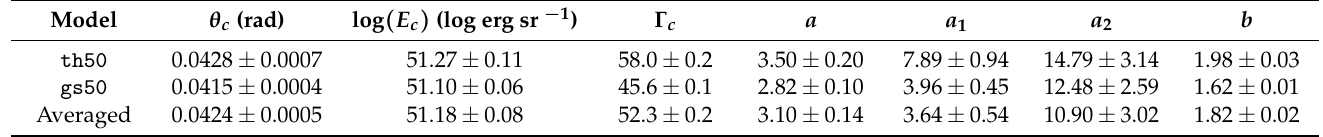
Figure 1. [Polar-plots] Face-on projections of the resultant jets/outflows. From the centre, θ = 0, to the edge, θ = 29 ◦ . Each row indicates a different initial jet structure described by: th50, gs50 , top to bottom. Where th indicates a top-hat profile for the injected jet structure, gs indicates a Gaussian structure, and the number is the logarithm of the jet power, i.e., 10 50 erg s − 1 . [ Left ]: The energy per steradian (erg sr − 1 ) for the resultant jet profiles. Energy per steradian is shown in the range 1 × 10 46 ≤ E/ Ω ≤ 7 × 10 51 erg sr − 1 . [ Centre ]: The resultant mass-averaged Lorentz factor for the same projection. Bulk Lorentz factor is shown in the range 2 ≤ Γ ≤ 100. [ Right ] The maximum and minimum energy per steradian (red) and Lorentz factor (blue) in rotation at each polar angle θ from the central axis for the model. The largest logarithmic variations are seen at wider angles where energies and Lorenz factors are lower—the average value is shown as a thick line within the shaded region. The purple, vertical dotted line indicates the jet opening angle as inferred by the afterglow break time for an on-axis observer—the black dashed line is the core opening angle found via fits to the mean angular profile, showing good agreement with the values inferred via the jet break [16]. The grey shaded area indicates the region within which we do not expect detectable γ -ray emission due to opacity arguments, see Equation (5), where we have assumed η = 0.15, T dur = 0.1 s, and δ t = 0.1 s—the lighter grey region indicates the limit using the minimum Γ value, while the darker region indicates the limit using the maximum Γ value for each angular segment. The pink, dash-dotted line indicates the maximum angle for γ -ray emission considering only the opacity due to electrons that accompany baryons in the jet. The yellow dashed line indicates the approximate functional shape of the jet profile in terms of energy with the fainter line at wider angles showing the profile without the energy cut-off, while the cyan dashed line represents the Lorentz factor profiles— the fit values for θ c , a and b in each panel are those for the analytic function in Equations (1)–(3) (see text for details). Table 1. Analytic jet structure profile parameters, see Equations (1)–(3) plus text, from fits to the mean energy and Lorentz factor with polar angle for each simulation and the averaged profile, see Section